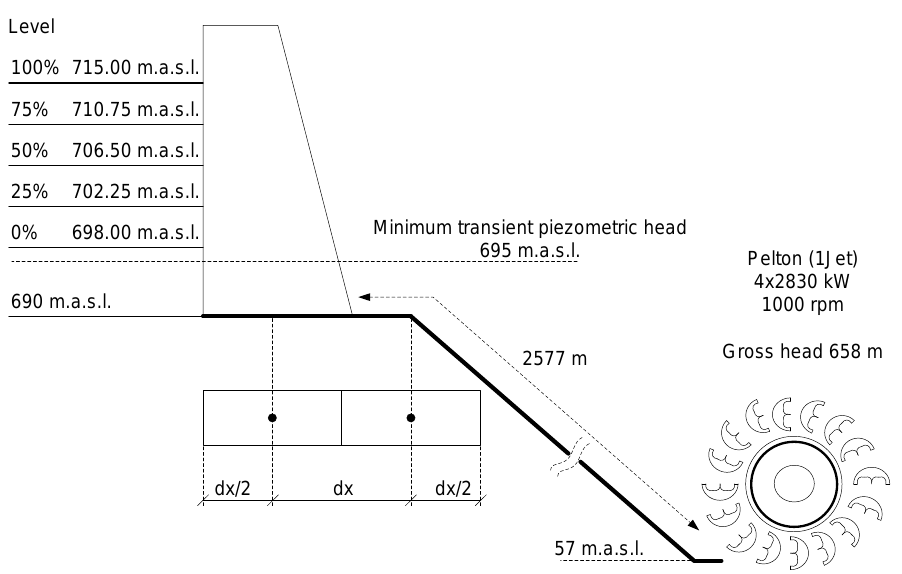
Figure 3. El Hierro hydropower plant, simplified hydraulic diagram.